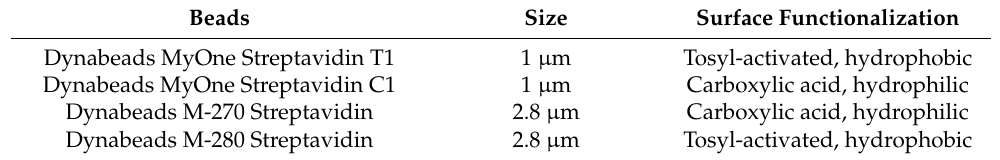
Table 1. Overview of tested